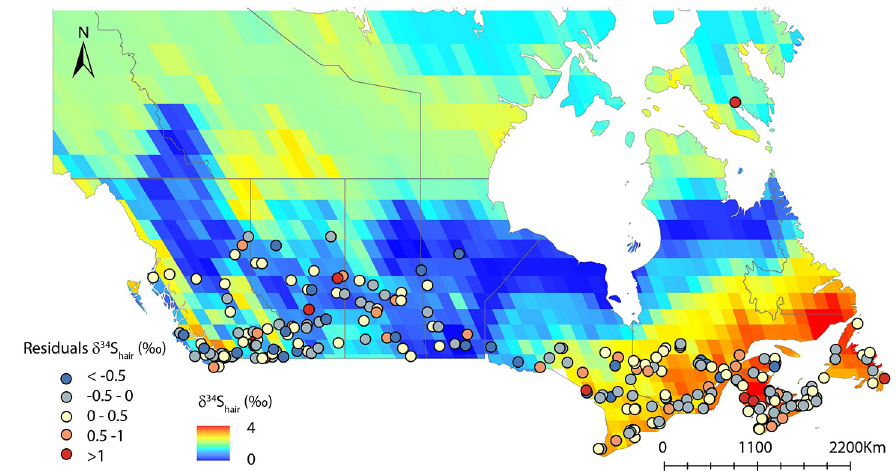
Fig 8. Predicted spatial δ 34 S hair variability using rainfall, salt aerosol, and soil pH as predictors (resampled at 10,000km 2 ). Colored points represent the associated residuals (modeled δ 34 S hair values–observed δ 34 S hair values). Administrative boundaries are from http://www.naturalearthdata.com/. This map was generated in Rx64 3 4.2 (https:// www.r-project.org/).